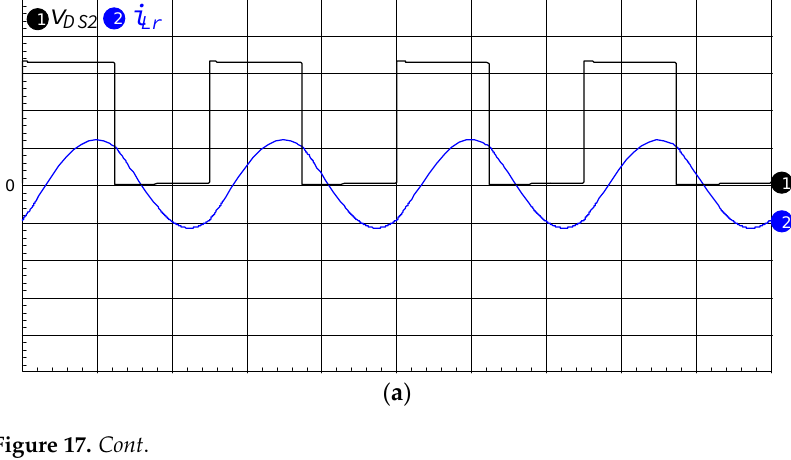
Figure 16. ( a ) Simulated and ( b ) measured inductor current i LB1 (1 A/div); time scale: 10 μs/div.